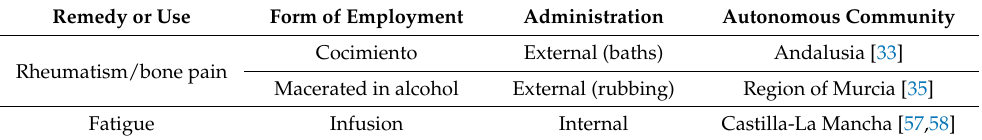
Table 4. Compilation of the medicinal uses of Chiliadenus glutinosus as a remedy for diseases of the locomotor system in Spain, compiled from the existing specific literature.